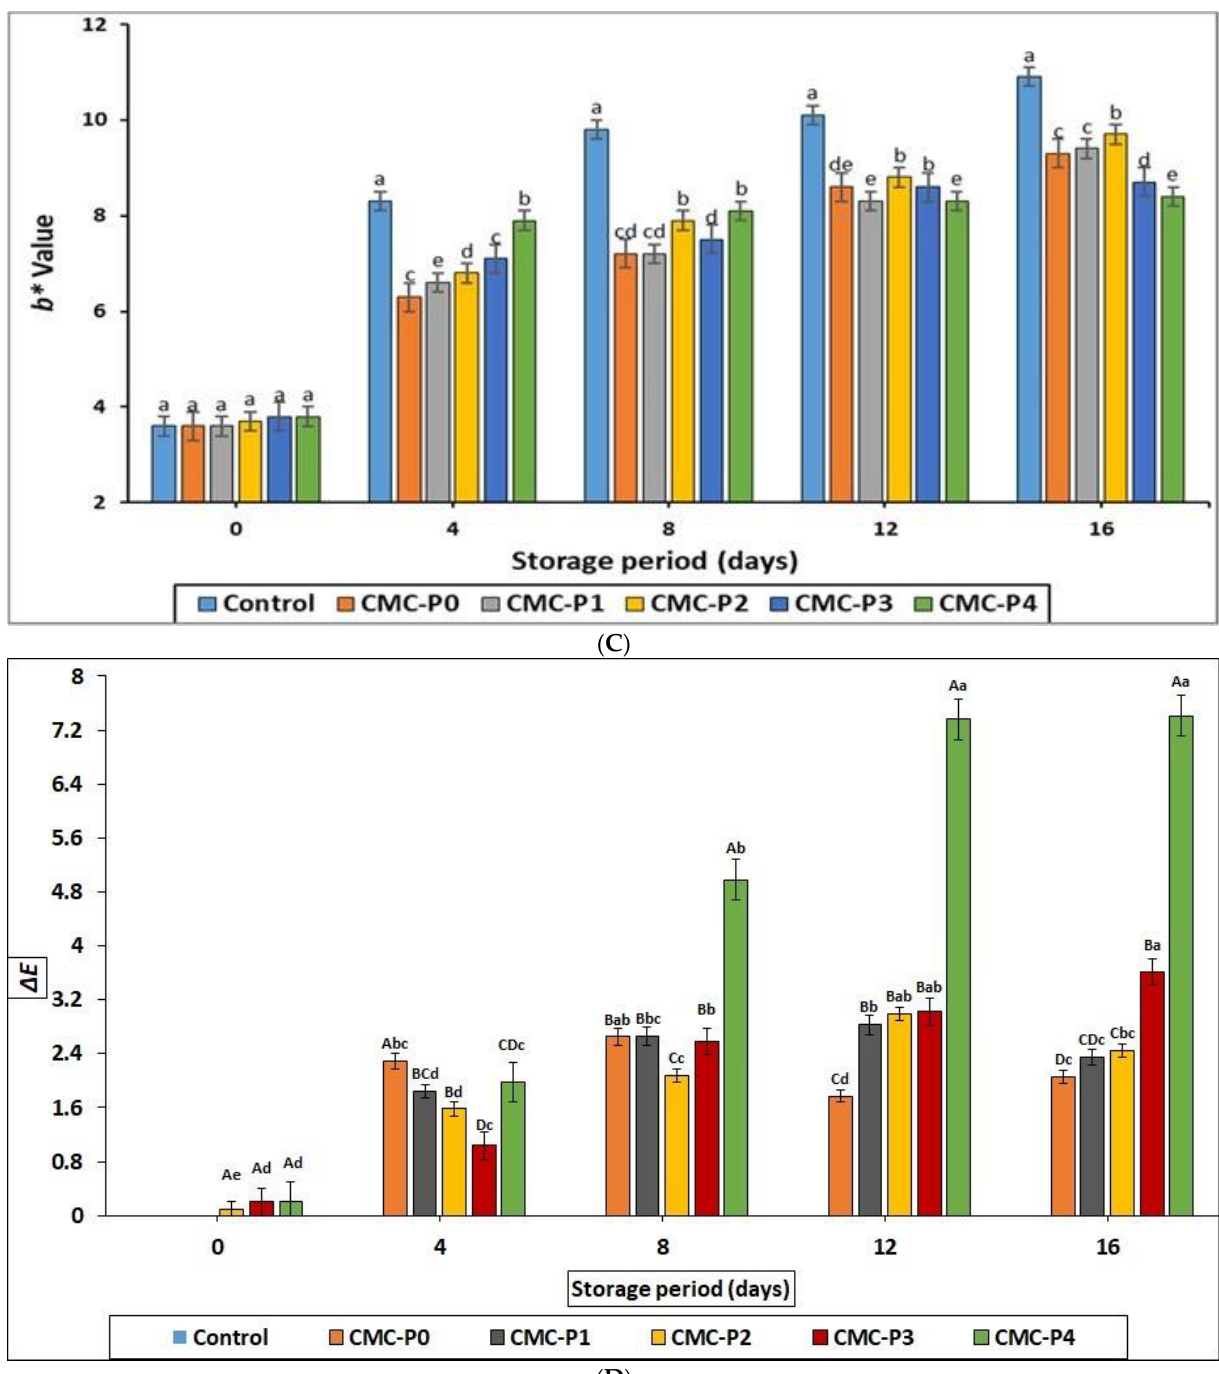
Figure 3. The impact of the applied coatings on all color characteristics: ( A ) L* value, ( B ) a* value, ( C ) b* value, and ( D ) ∆E (total color difference) of the chicken breast meat samples during storage at 2 °C for 16 days. Control : Uncoated chicken breast meat samples (soaked samples in sterile distilled water). CMC-P0 : CMC-coated chicken breast meat samples with 0% EPE. CMC-P1 : CMC-coated chicken breast meat samples with 1% EPE. CMC-P2 : CMC-coated chicken breast meat samples with 2% EPE. CMC-P3 : CMC-coated chicken breast meat samples with 3% EPE. CMC-P4 : CMC-coated chicken breast meat samples with 4% EPE. a – g : Within a column, different superscripts indicate significant differences ( p ≤ 0.05 ).